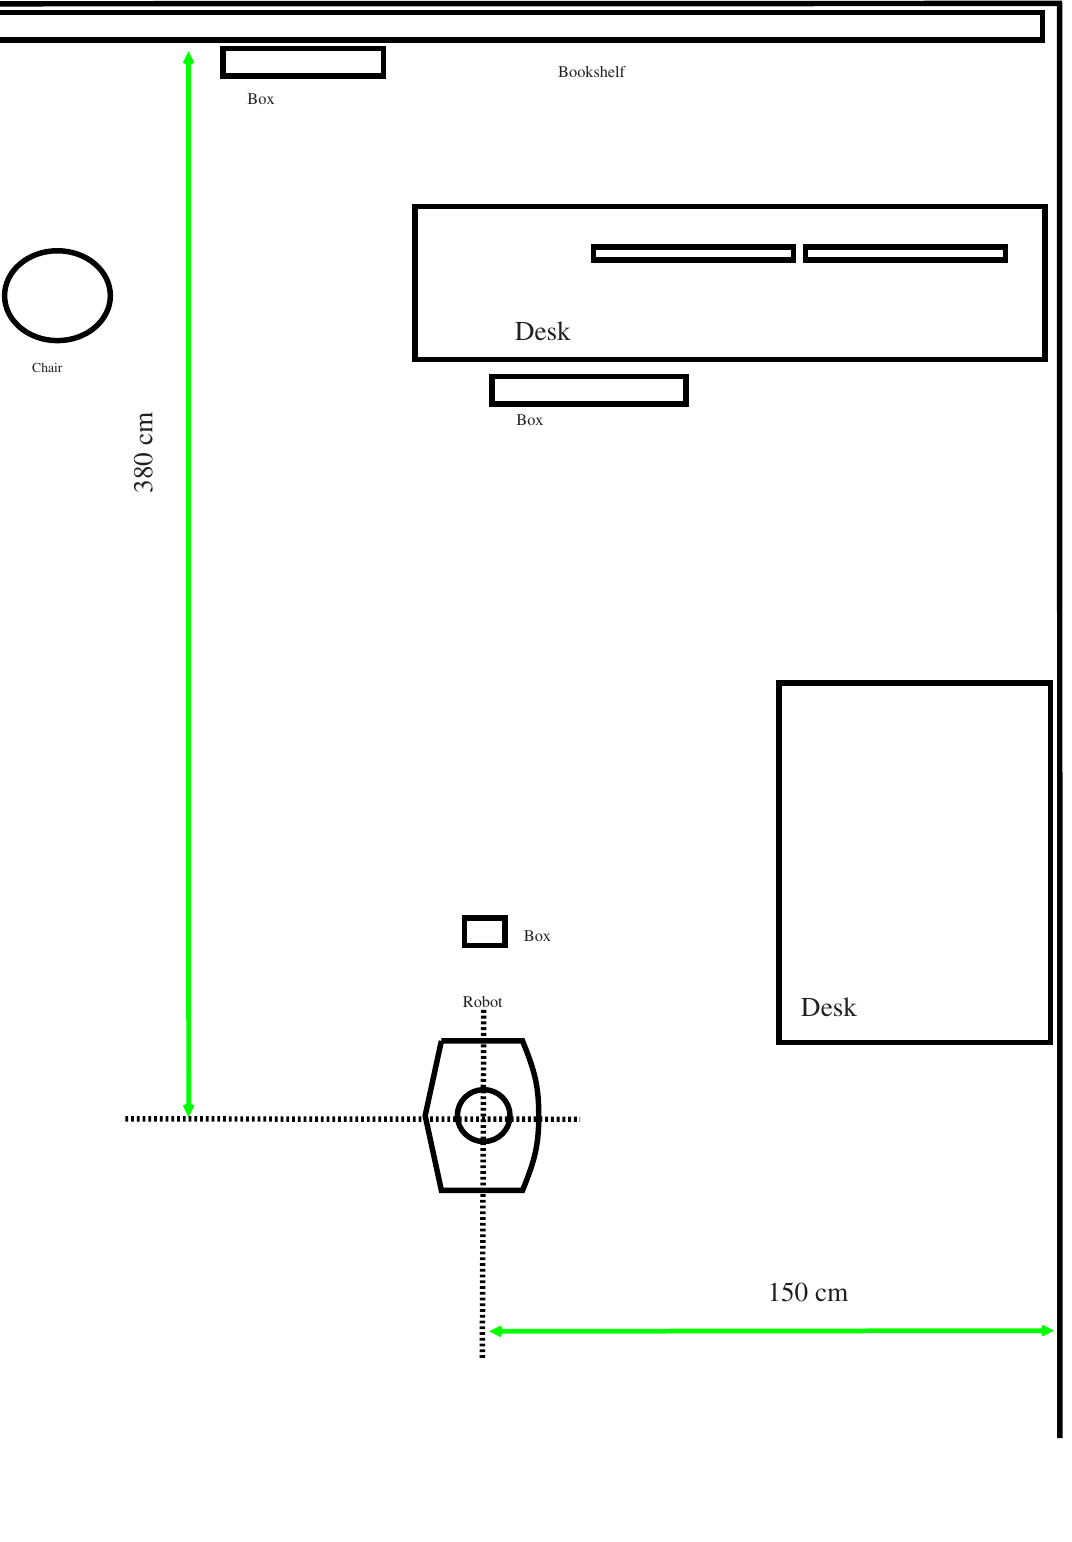
Figure 7. The experimental